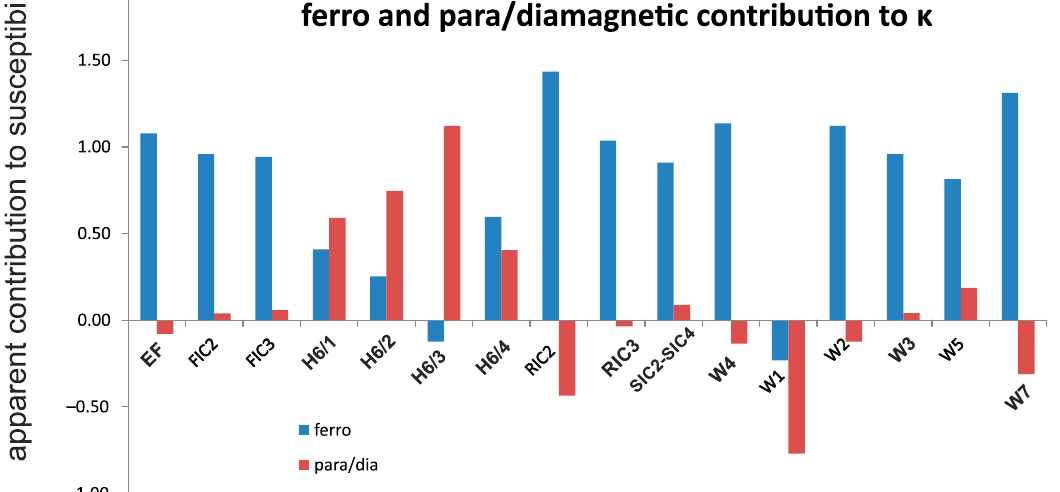
Figure 13. A comparison of the contribution of ferro-, para-, diamagnetic phases to initial susceptibility (normalized by initial slope value for uncorrected curve). Samples W1 and H6/3 do not yield realistic values for the ferromagnetic phase due to very weak signals. EF, empty filter.